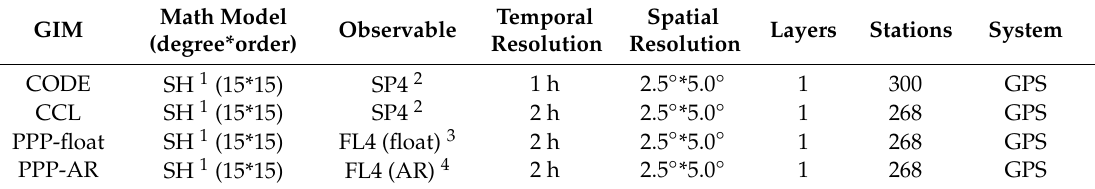
Figure 1. Distribution of 268 stations in the ionospheric modeling network. Table 3. Details of the global ionosphere models used for comparison.